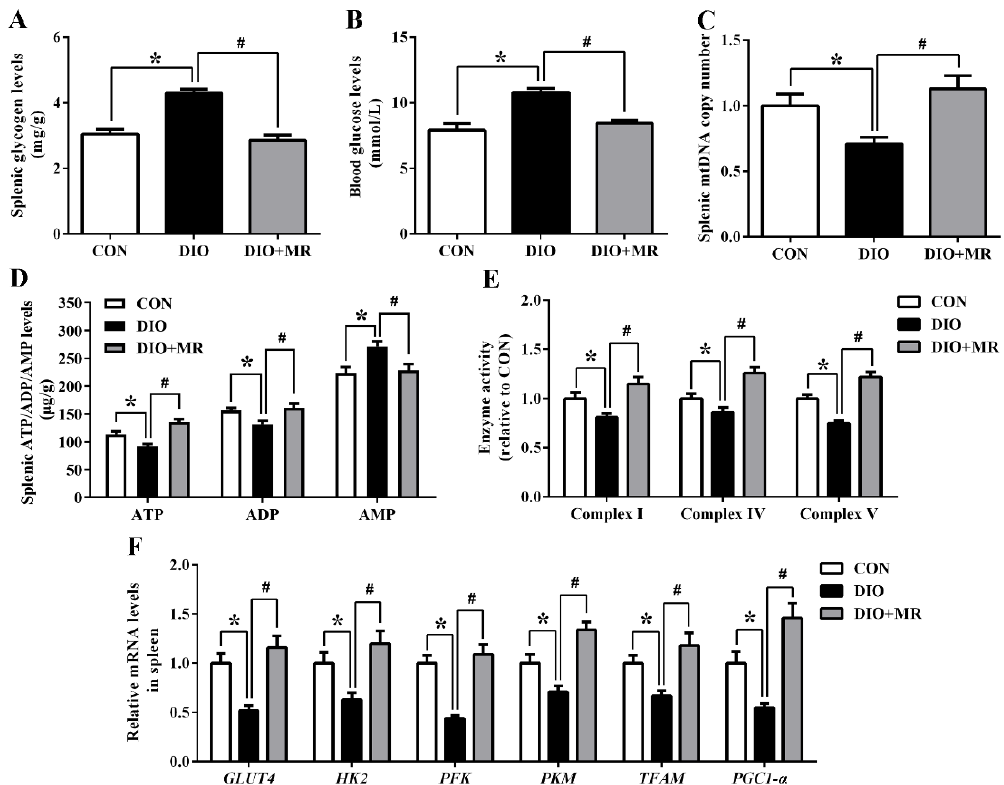
Figure 7. Effects of MR on spleen glycogen levels ( A ), blood glucose levels ( B ), splenic mtDNA copy number ( C ), spleen ATP/ADP/AMP levels ( D ), respiratory chain enzyme activities ( E ), and glucose metabolism-related mRNA expression levels ( F ) in obese mice. ATP, adenosine triphosphate; ADP, adenosine diphosphate; AMP, adenosine monophosphate; GLUT4 , glucose transporter 4; HK2 , hexokinase2; PFK , phosphate fructose kinase; PKM , pyruvate kinase; TFAM , mitochondrial transcription factor A; PGC-1 α , peroxisome proliferator-activated receptor gamma coactivator 1-alpha. All data are shown as mean ± SEM ( n = 10). * p < 0.05 versus CON; # p < 0.05 versus DIO.